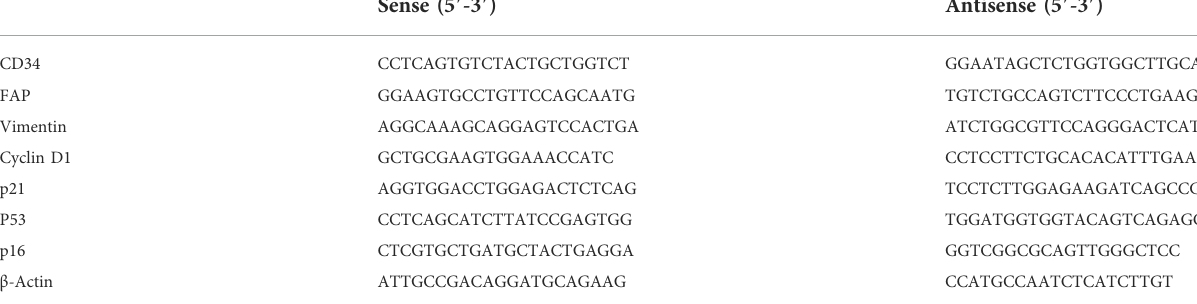
TABLE 1 qPCR primers speci fi c for p21, p53, p16, Cyclin D1, CD34, FAP, vimentin and β